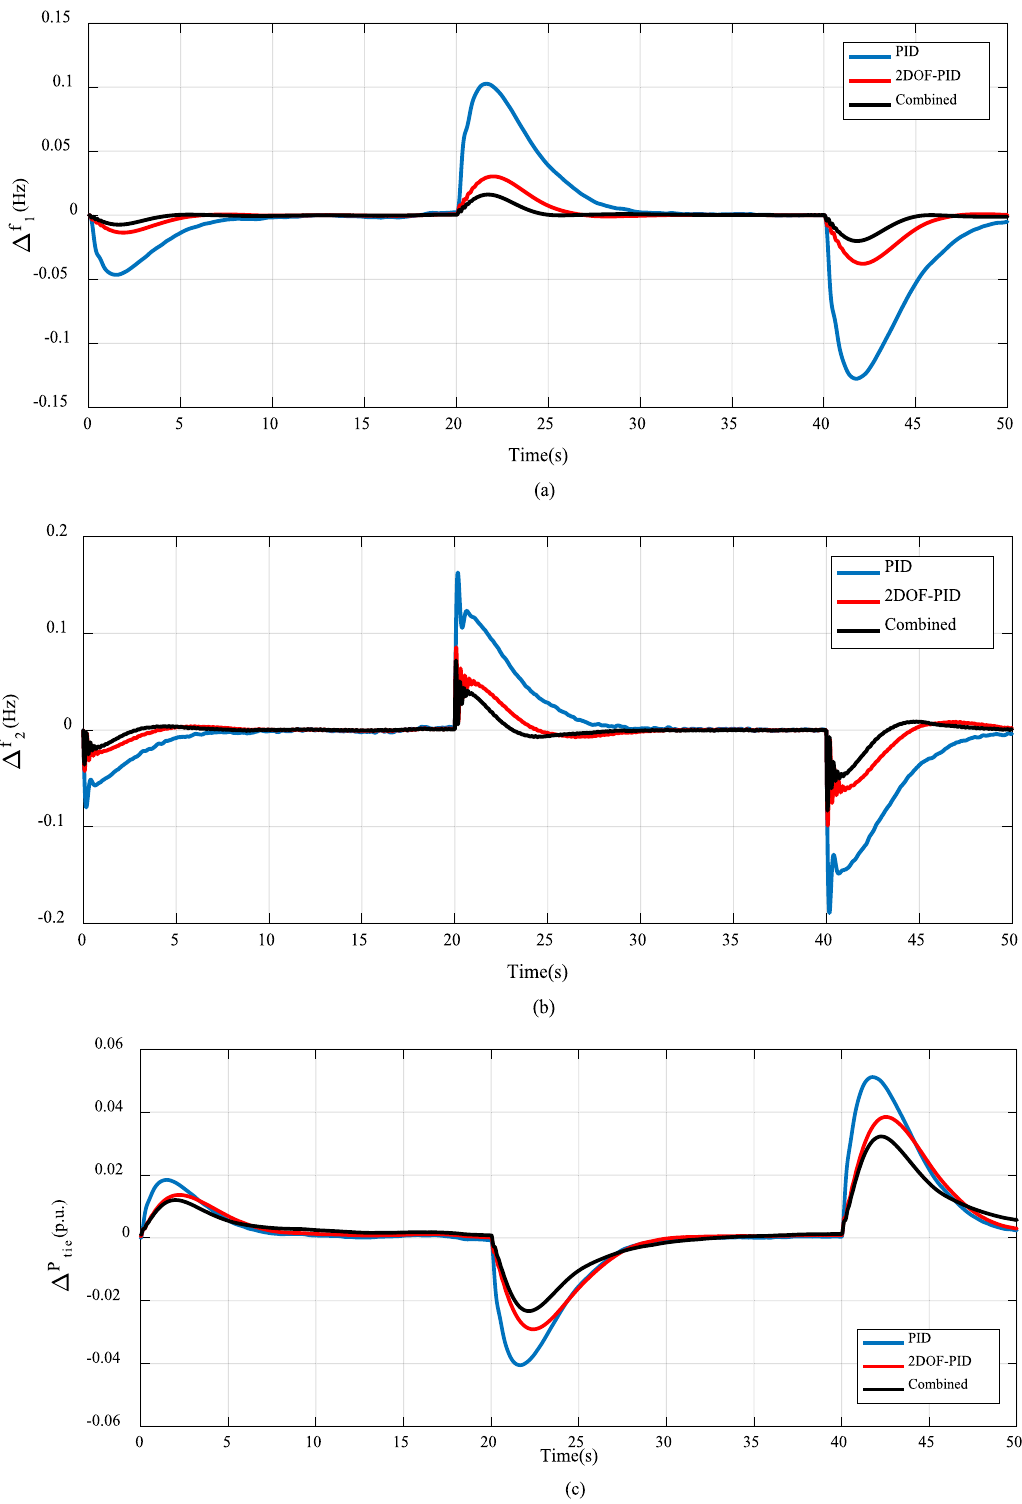
Fig. 11 Improvement in responses with the combined controller during simultaneous load change (as shown in Fig. 12) and wind disturbances ( 6% at 20 s and 12% at 40 s). (a): frequency deviations of area I; (b): frequency deviations of area II; (c): tie line power + −